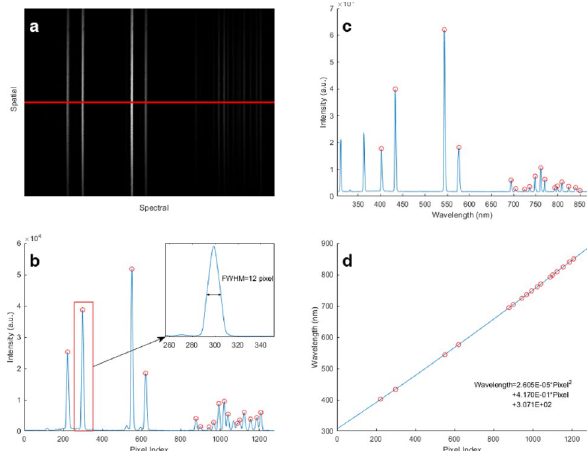
Figure 4. Calibration with an Hg–Ar lamp. ( a ) raw image; ( b ) intensity distribution on pixels; ( c ) spectrum measured by our spectrometer; ( d ) polynomial fitting result.